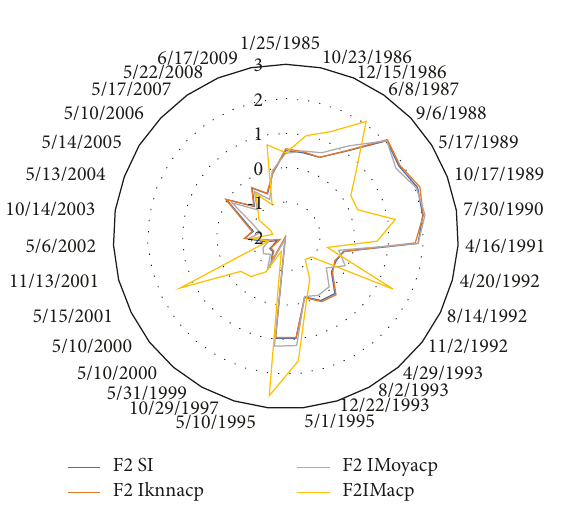
Figure 7: Evolution of component 2